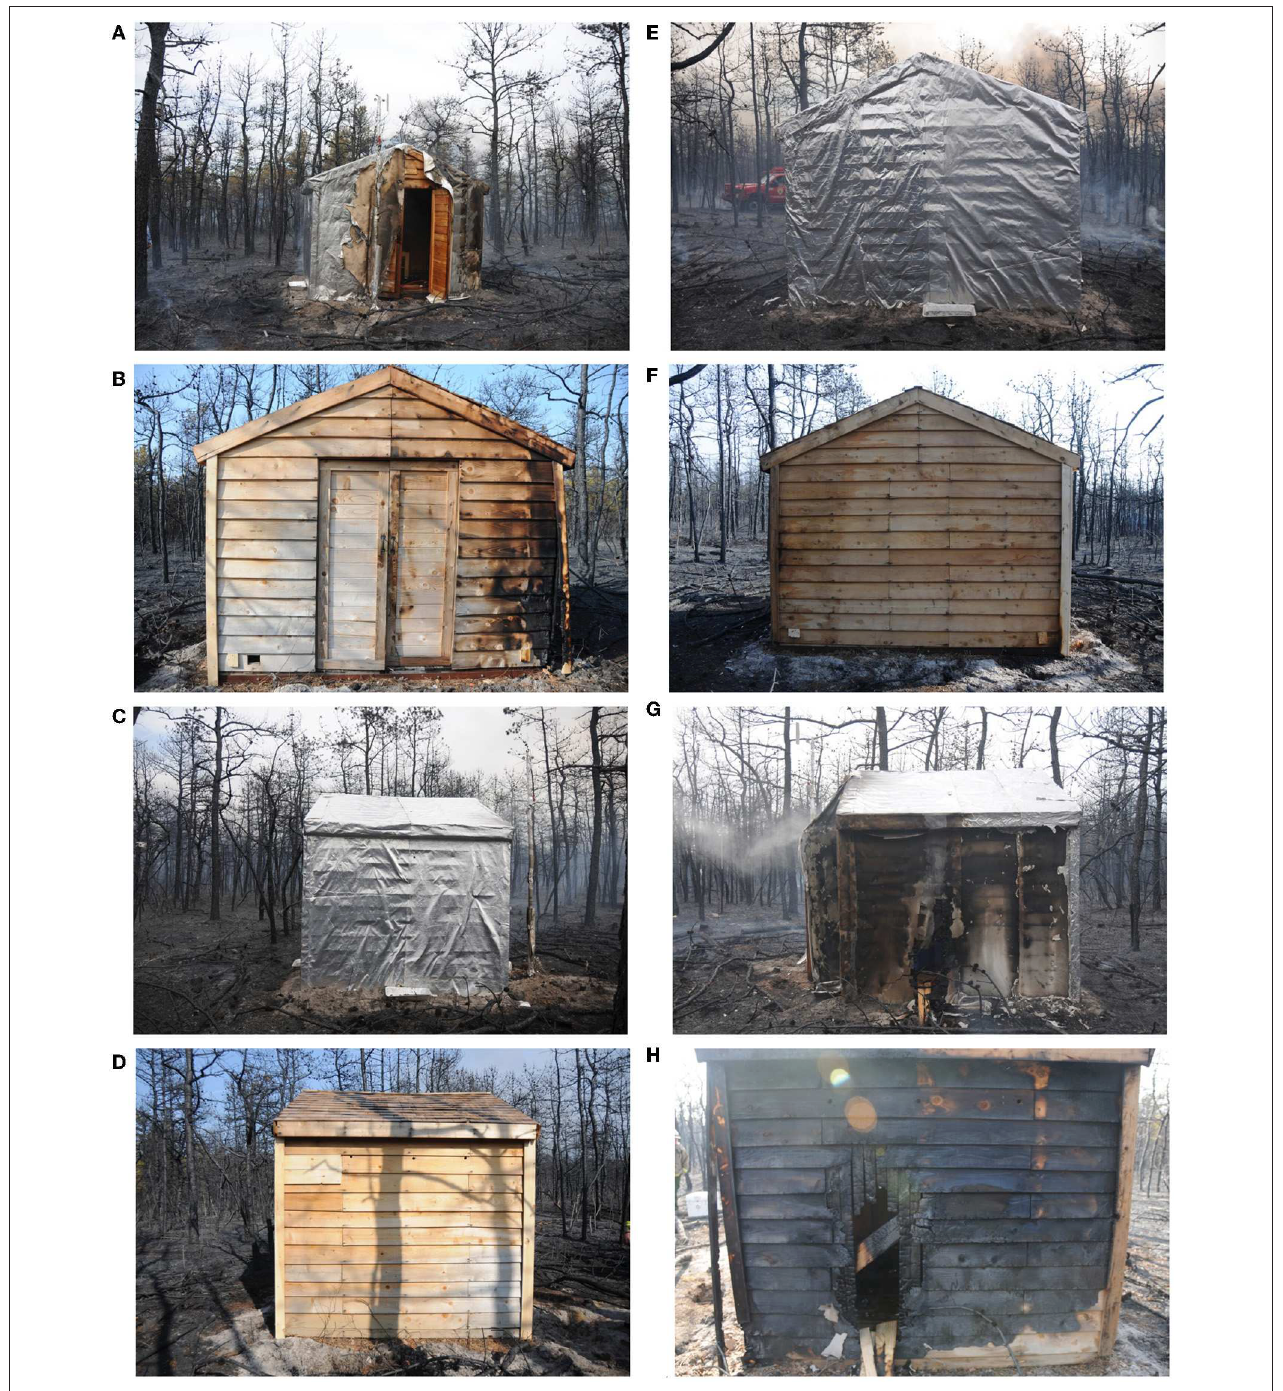
FIGURE 10 | Fire blanket and wood structure damage after the prescribed burn (see Table 4 for the blanket materials). (A,B) Wall “A” facing south, (C,D) Wall “B” facing west, (E,F) Wall “C” facing north, and (G,H) Wall “D” facing east.